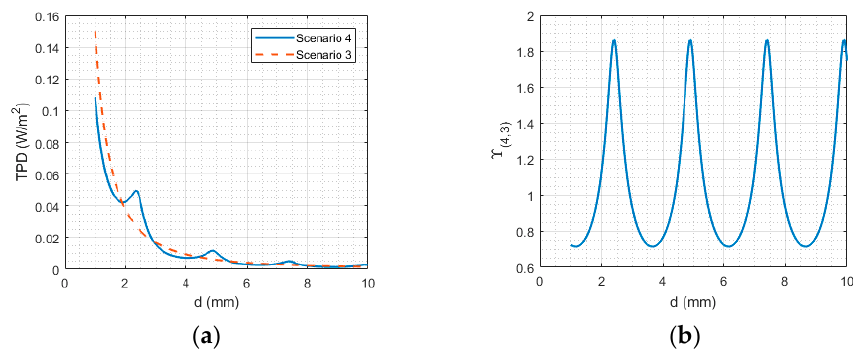
Figure 5. Plane-wave illumination with free-space losses without (scenario 3) and with (scenarios 4) PEC: ( a ) TPD; ( b ) TPD variations due to presence of PEC. Table 1. Average 𝚼 ((cid:2870),(cid:2869)) over Δ d.